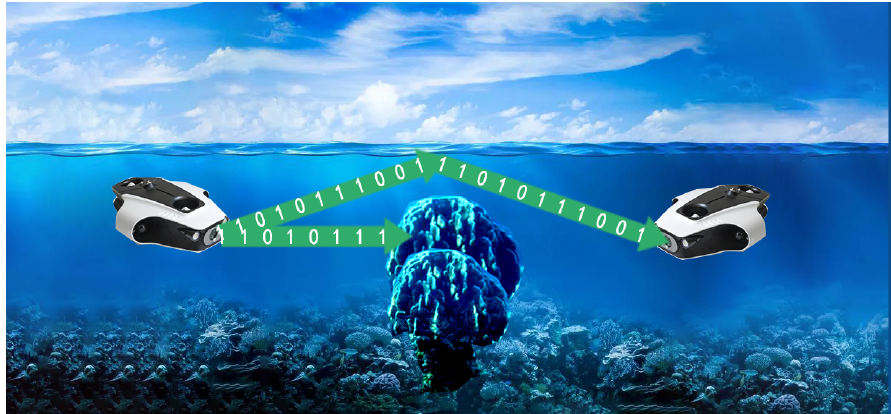
Figure 2. Illustration of underwater vehicles using total reflection communication links at the air- water